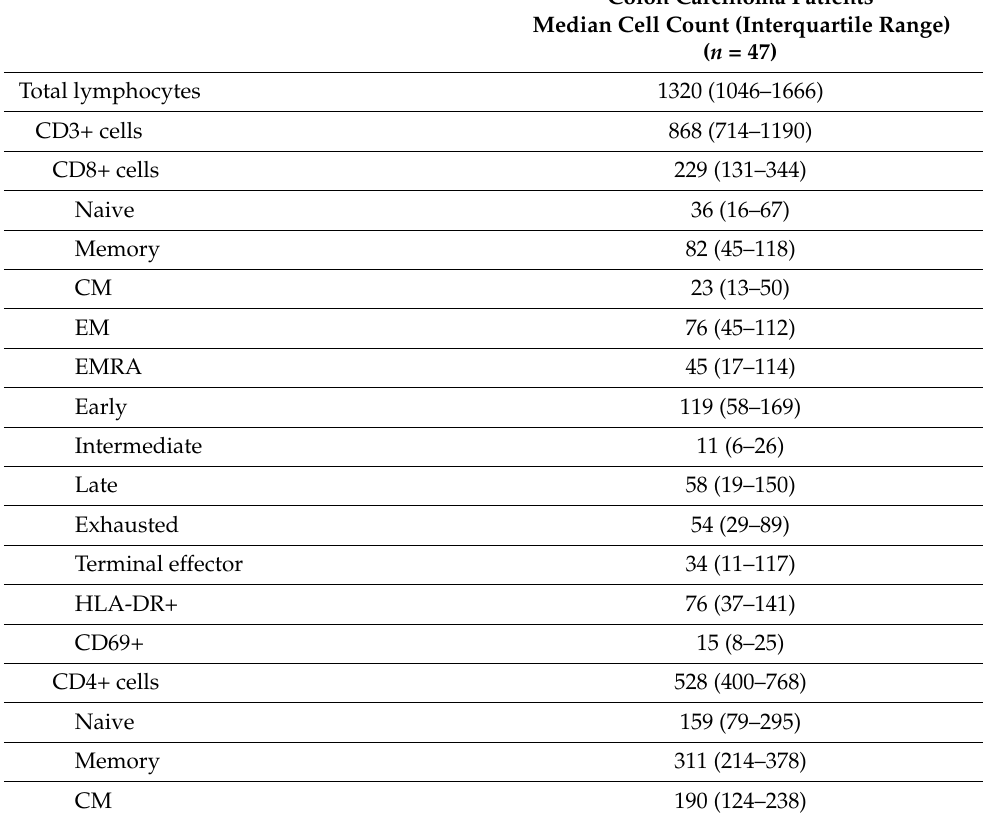
Table 2. Peripheral blood and tumor-infiltrating lymphocytes of the entire cohort. Cell counts are given as the median value/ µ L (interquartile